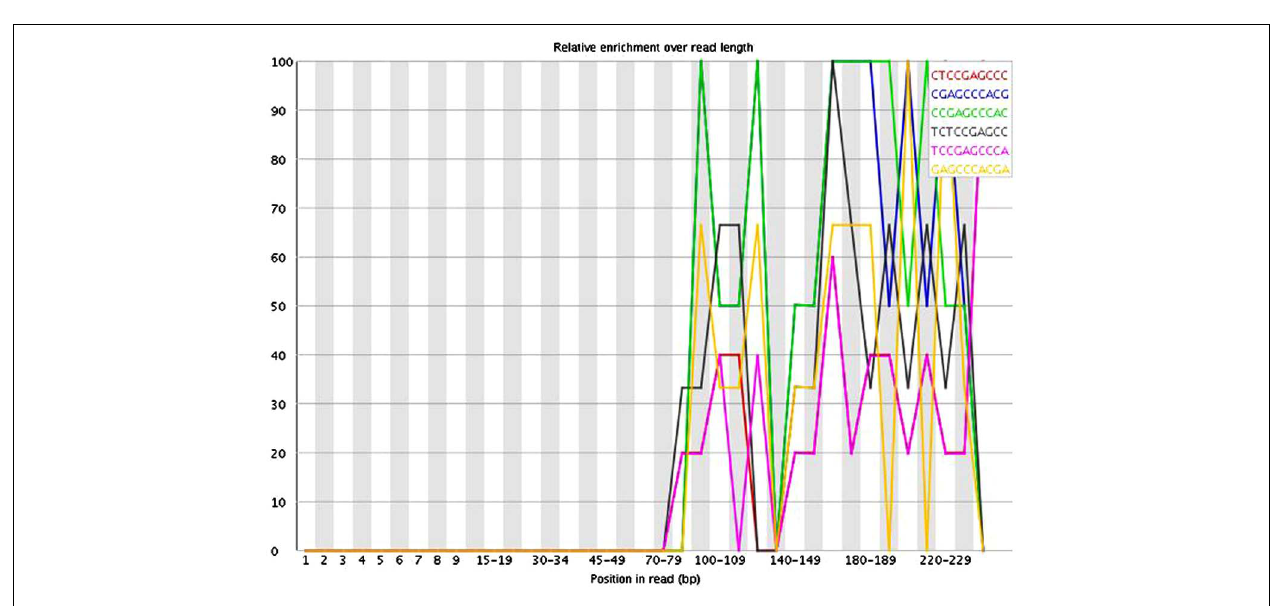
FIGURE 4 | FastQC plot of the relative enrichment of k-mers of 10 nucleotides along the length of the read for a single library in the dataset.